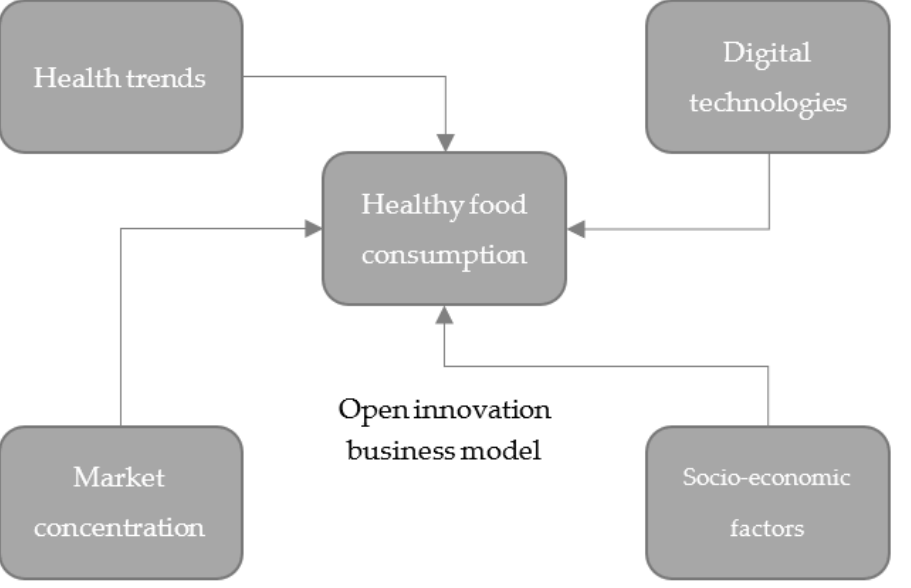
Figure 3. A conceptual framework of this study.